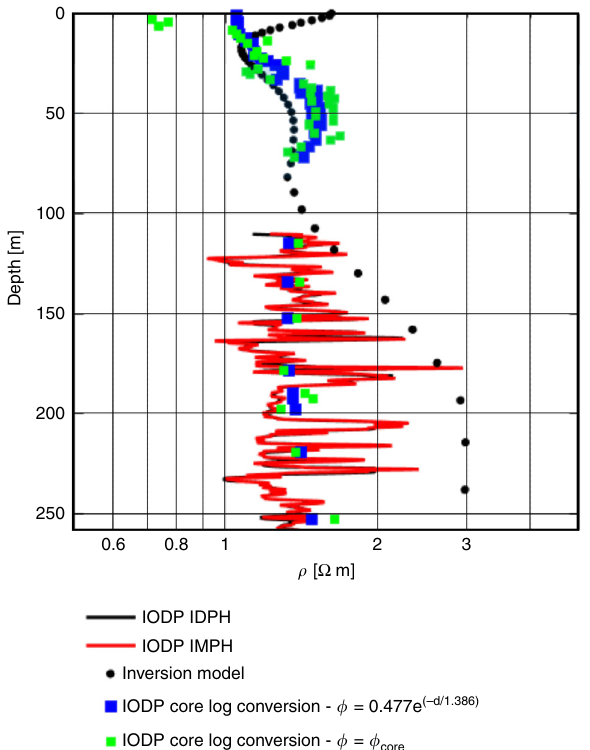
Fig. 5 Validation of the resistivity-depth variations data for line 2 with resistivity measurements from borehole U1353. Downcore variations in resistivity derived from CSEM measurements (inversion model, shown as black circles), measured resistivities in borehole U1353 (IDPH = phasor deep induction log, shown as black line; IMPH = phasor medium induction log, shown as red line), and resistivities based on estimates using pore water salinity values from U1353 and the porosity – depth function derived from U1353, shown as blue squares, or the measured porosity values from U1353, shown as green